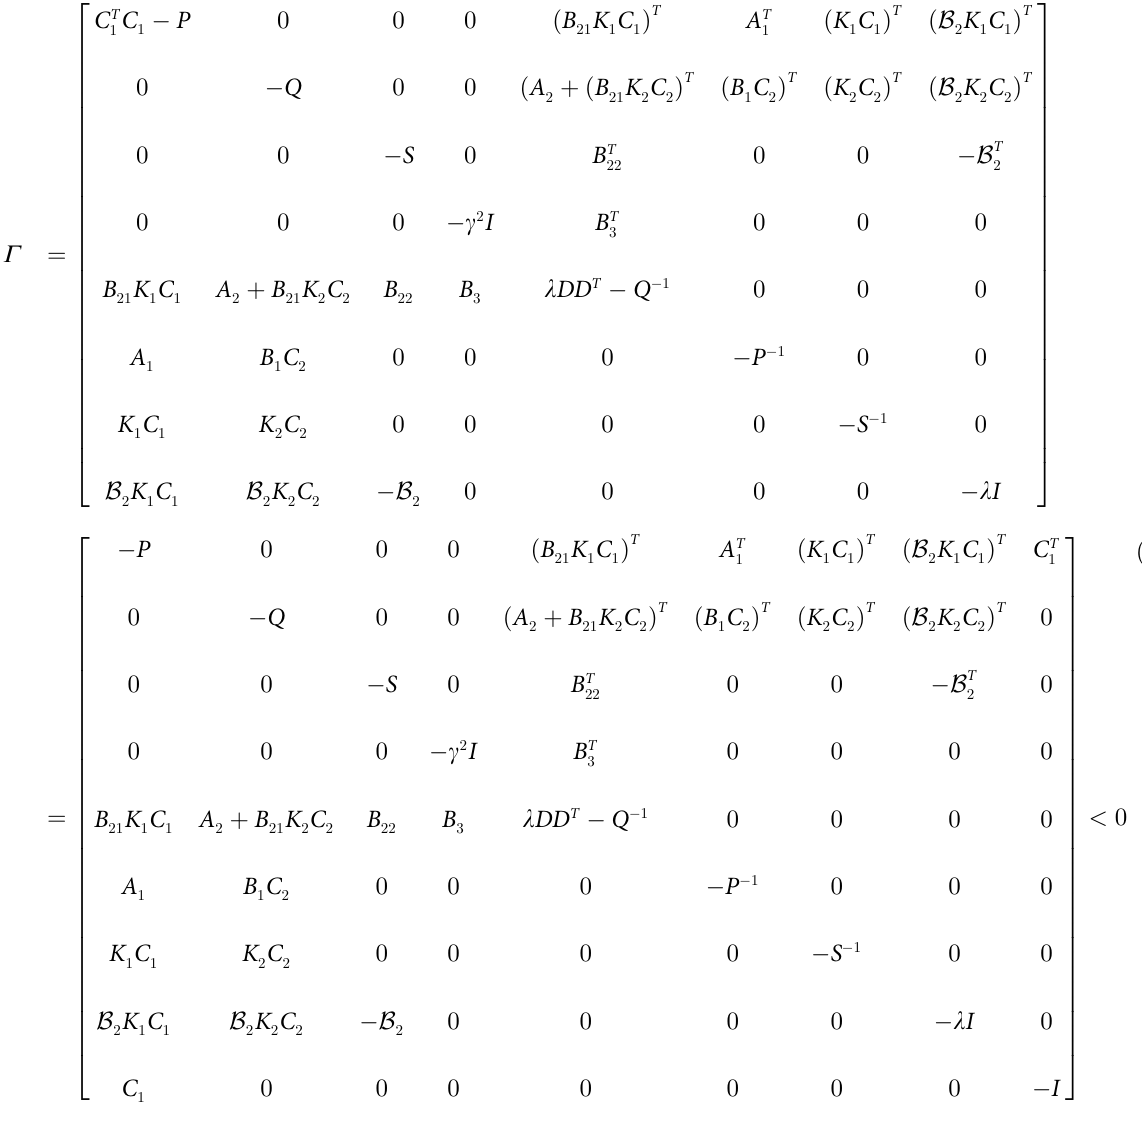
Step 1 : The continuousclosed-loopsystem parametersare derived based on Fig 3. Step 2 : The continuoussystem parametersare discretized . Step 3 : The convex optimizationproblem (Eq (10)) is solved to obtain the feasiblesolutionsin terms of positivedefinite matricesX , Y , and Z and matrices W 1 , W 2 , and ρ (cid:3) . Step 4 : The controllerparametersK 1 , K 2 , and γ are derived based on Theorem